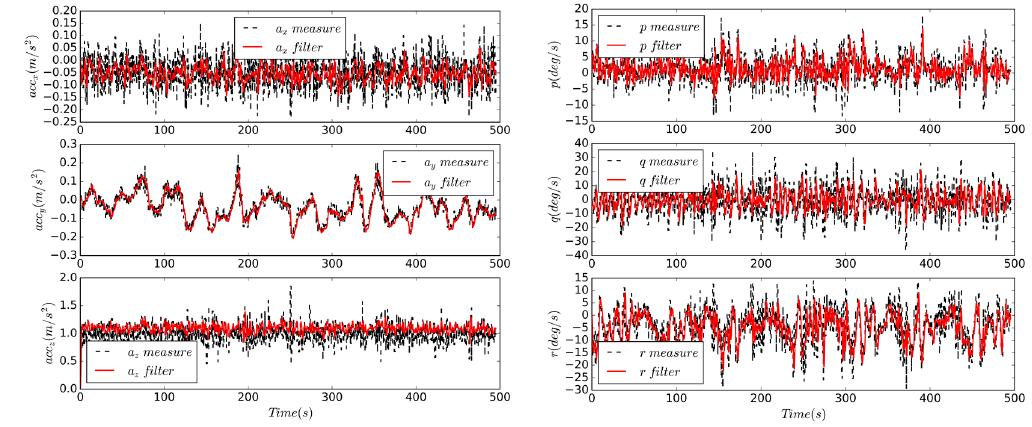
( b ) Flight parameters ( c ) Four ‐ side flight profile Figure 15. Flight path and state parameters during cruise process. The field flight test can not only verify the feasibility of the state estimation algorithm, but also calibrate some parameters in the modeling process, such as sensor measurement bias, noise and covariance matrix R . The Finite Impulse Response (FIR) filter is used to filter the flight data [27], as shown in Figure 16. The measurement result of the IMU is regarded as the raw data, and the filtered parameter is regarded as the real state. The bias and noise of the sensor model can be obtained by the following equations: